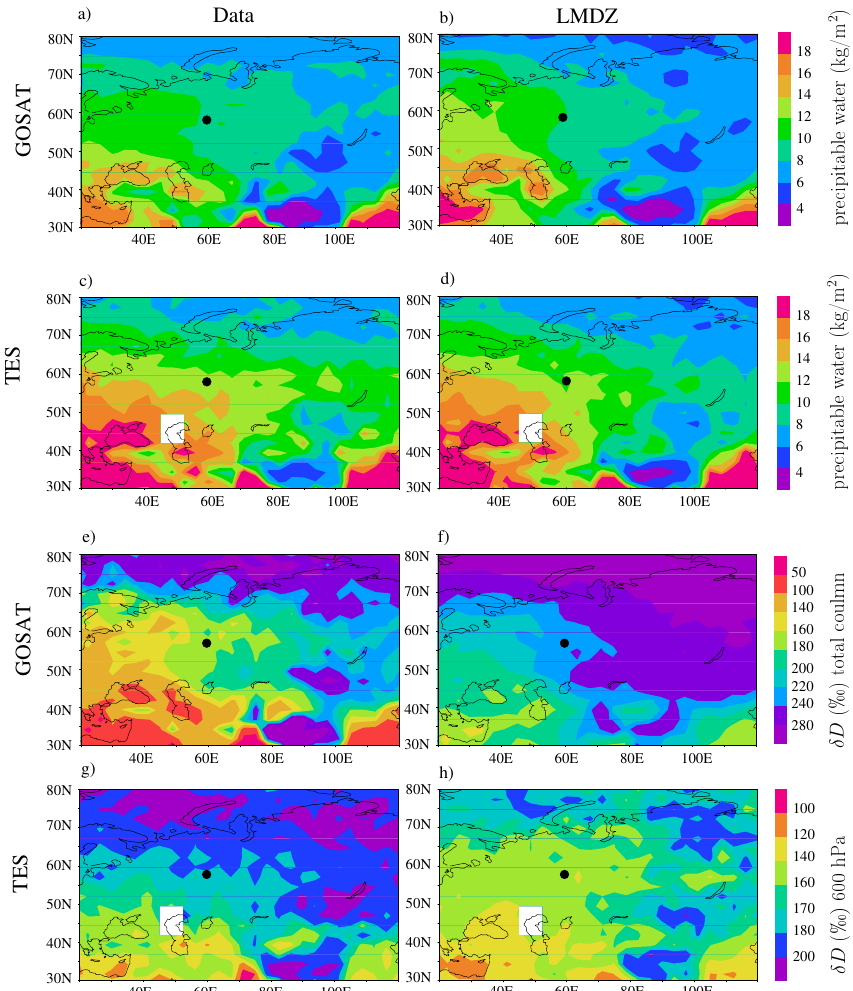
Fig. 2. Annual mean maps of observed (left) and simulated (right) precipitable water (a-d) and δD in the total column water vapor (e-g) as observed by GOSAT (a-b, e-f), and by TES (c-d, g-h). The black dot indicates the location of Kourovka. Here we plot δD values without any subtraction because LMDZ happens to show values similar to those of GOSAT and TES. The black dot indicates the location of Kourovka.